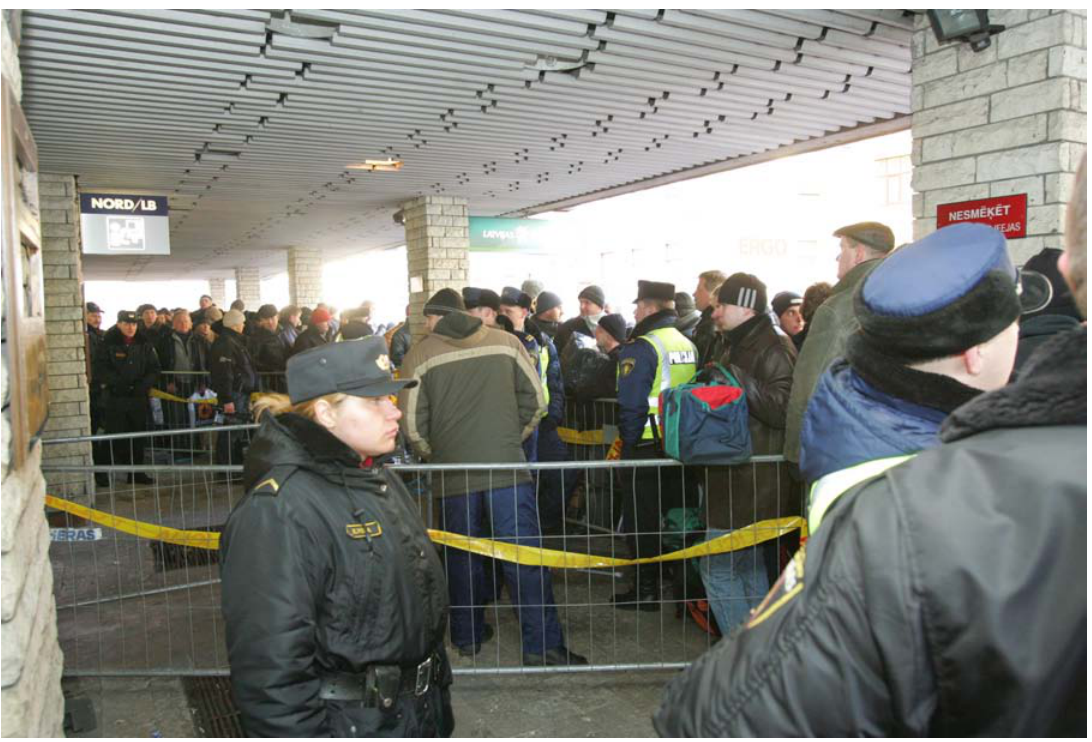
Fig. 2. On 20 March 2006 the municipal police is bringing order to the queue lined up to submit applications for EU struc- tural fund reception at the entrance of Latvian Investment and Development Agency. Photo – Aigars Egīte,